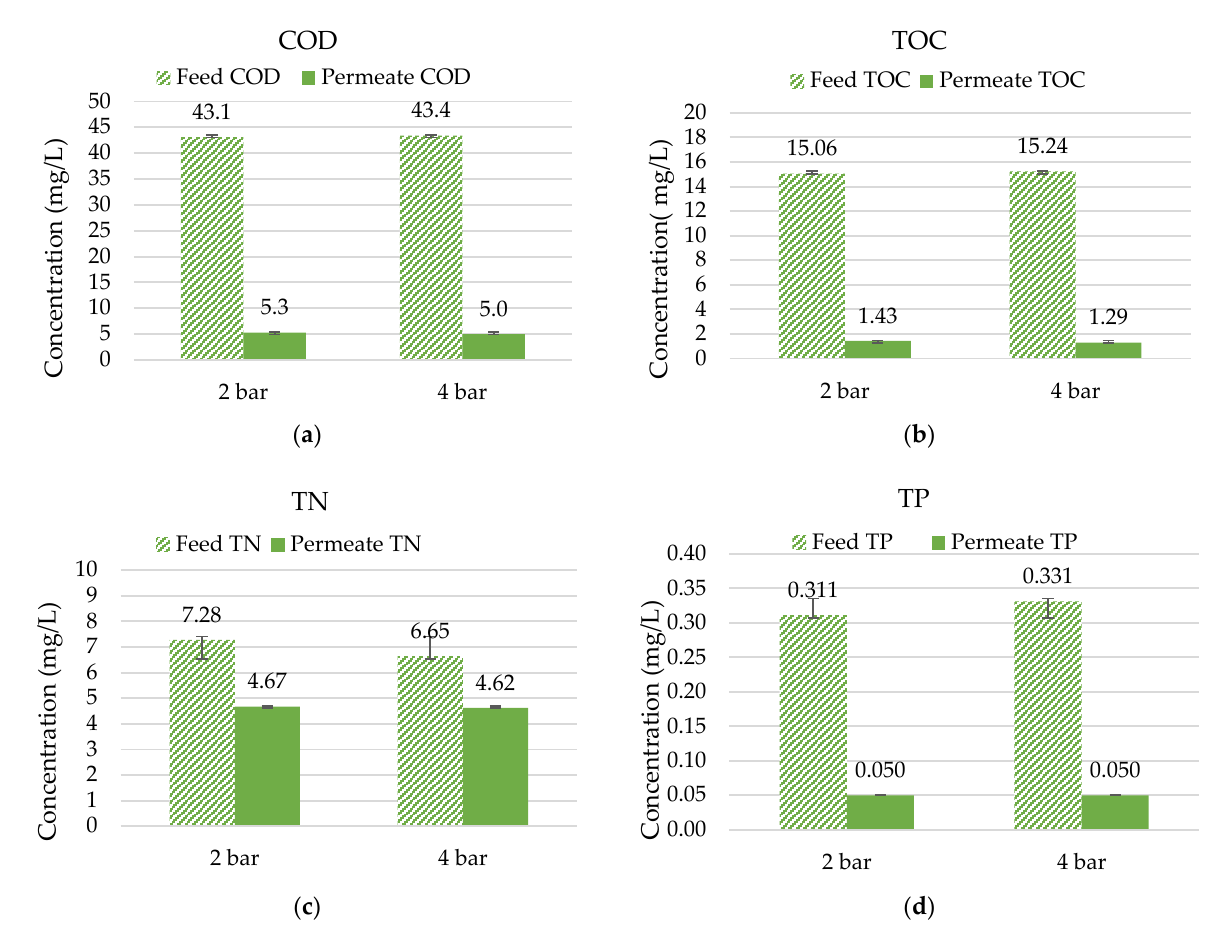
Figure 6. Rejection percentages in multi-channel hybrid membranes with treated wastewater (n = 4) of ( a ) COD; ( b ) TOC; ( c ) TN; and ( d ) TP.